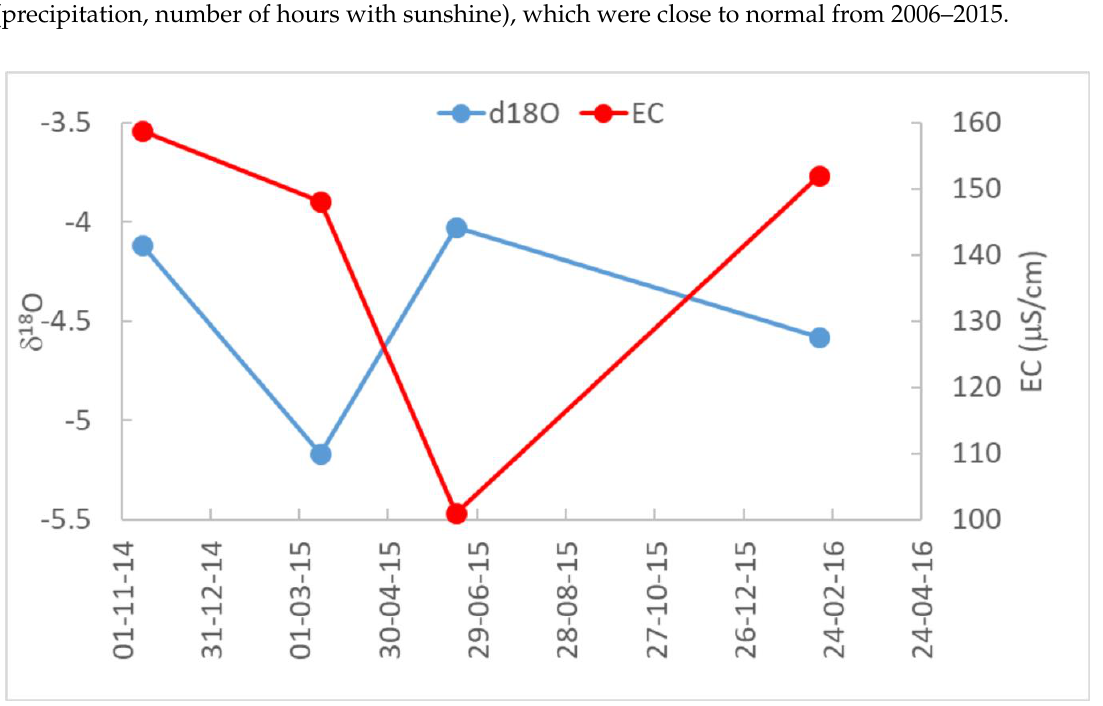
Figure 4. EC (mean of 140 S/cm) and 18 O (mean of −4.5‰) in Lake Tvorup Hul.